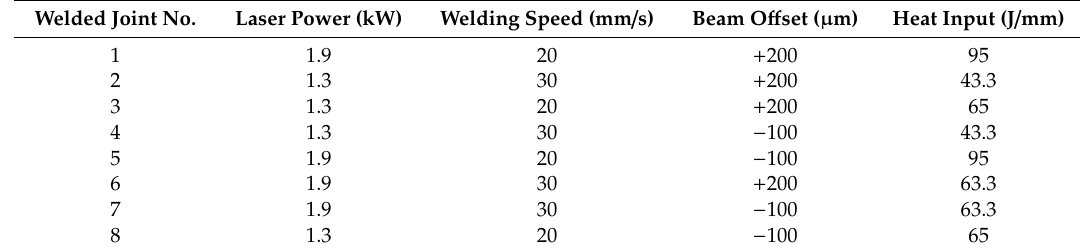
Table 5. Welding parameters used for